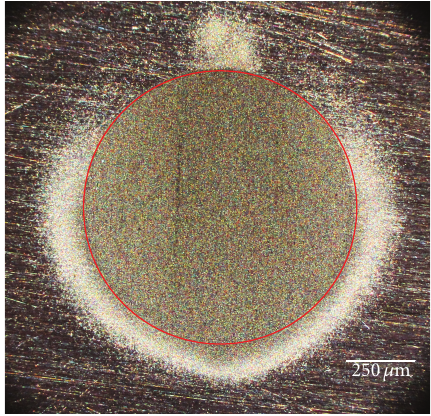
Figure 2: Crater on an AR sample with scuffed area around the